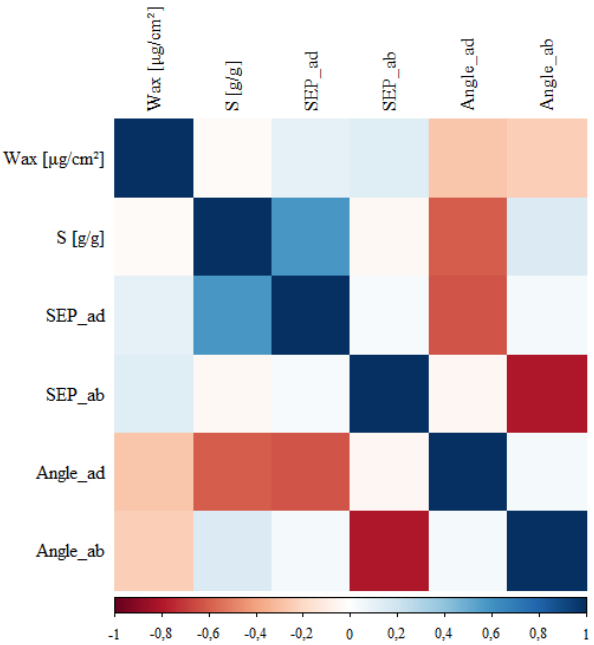
Figure 4. Correlation coe ffi cients between the analysed variables, the so-called heat map.Wax—the leaf wax content; S—canopy water storage capacity; SFP_ad—surface free energy of the upper leaf surface; SFP_ab—surface free energy of the lower leaf surface; Angle_ad—angle of contact with the upper leaf surface (adaxial side); Angle_ab—droplet angle of contact with the lower leaf surface (abaxial side);.